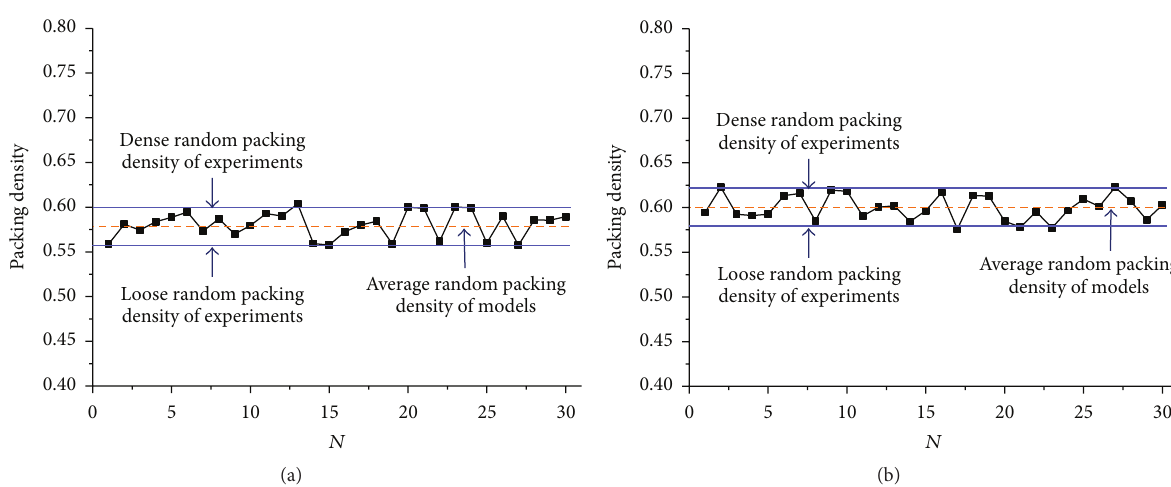
Figure 3: Comparison of the packing density between the model and the experiment. 𝑁 is the modeling number. (a) Diameter of balls ranging from 9 mm to 11mm. (b) Diameter of balls ranging from 4.5 mm to 5.5 mm.